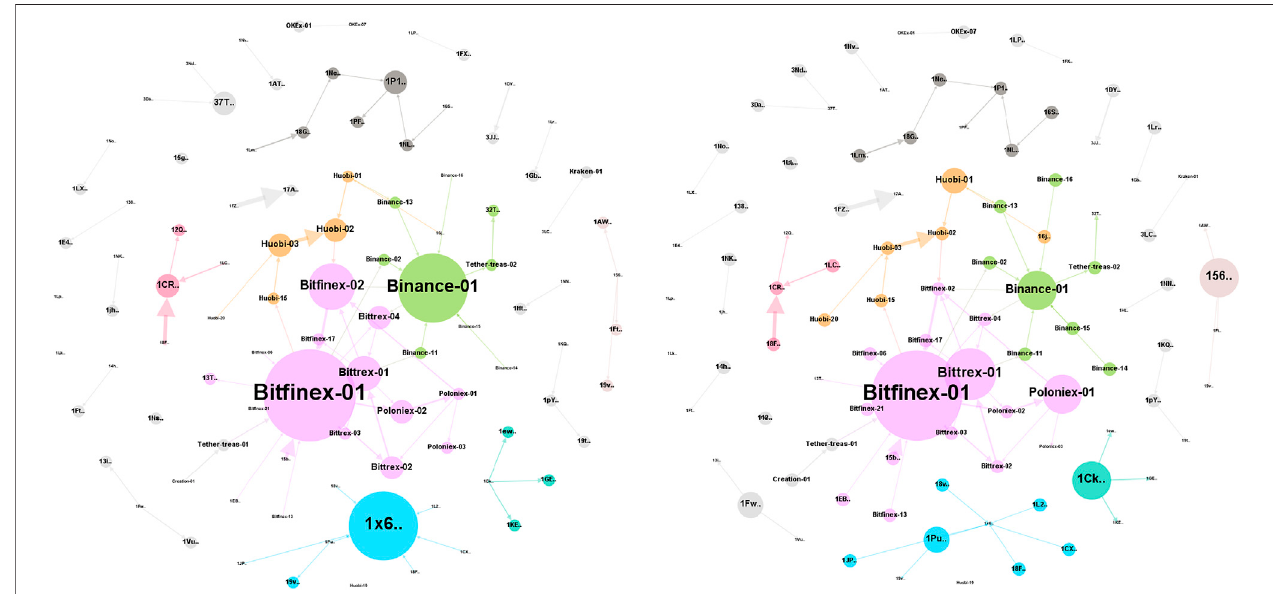
FIGURE 3 | Network graph from the top 100 transactions until March 2020. Colors are related to modularity class , and node sizes describe the nodes in-degree (left) and out-degree (right)